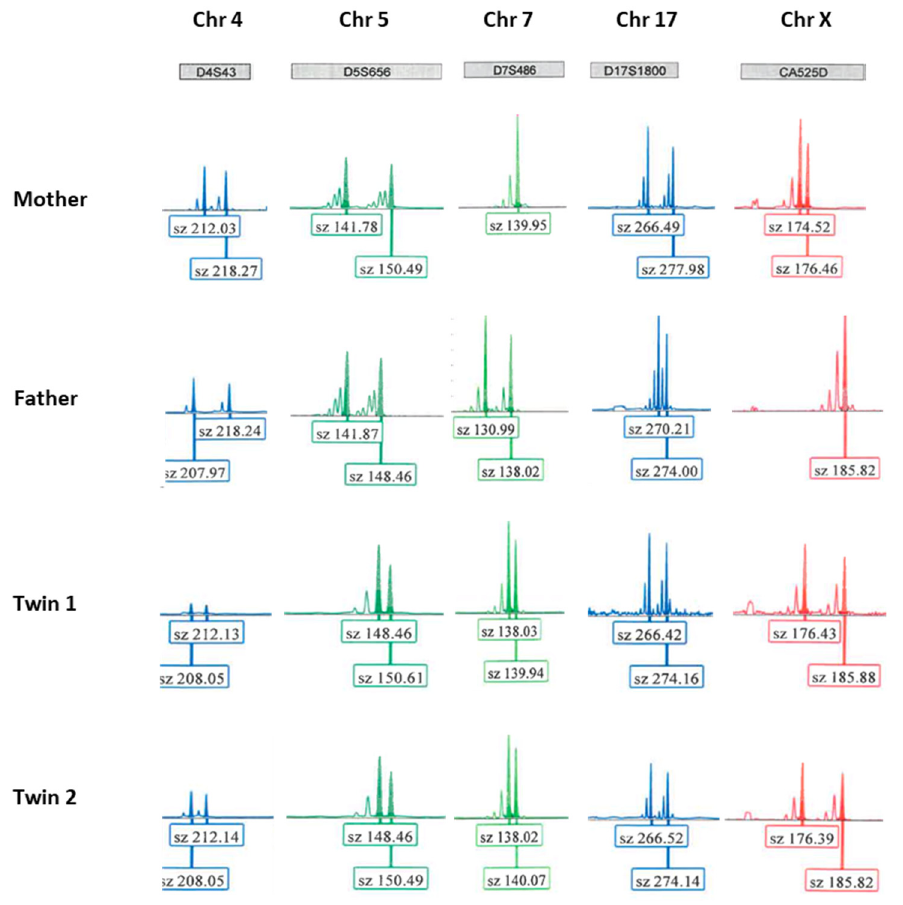
Figure 5. Example of electropherograms from the couple and the baby twins. The results obtained for 5 informative STR markers (D4S43, D5S656, D7S486, D17S1800, and CA525D, located on chromosomes 4, 5, 7, 17, and X, respectively) are shown. The sizes of the marker alleles (in bp) are indicated below the electropherograms. Sz: size.